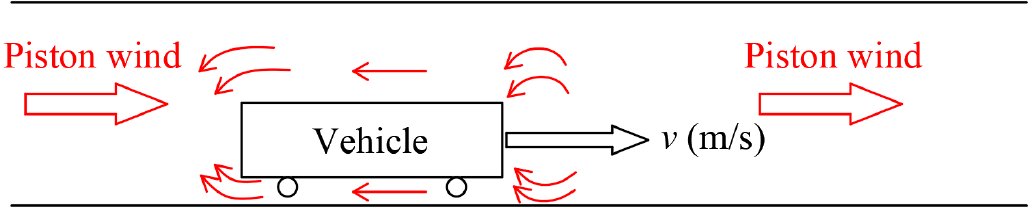
Figure 2. Piston wind inside the